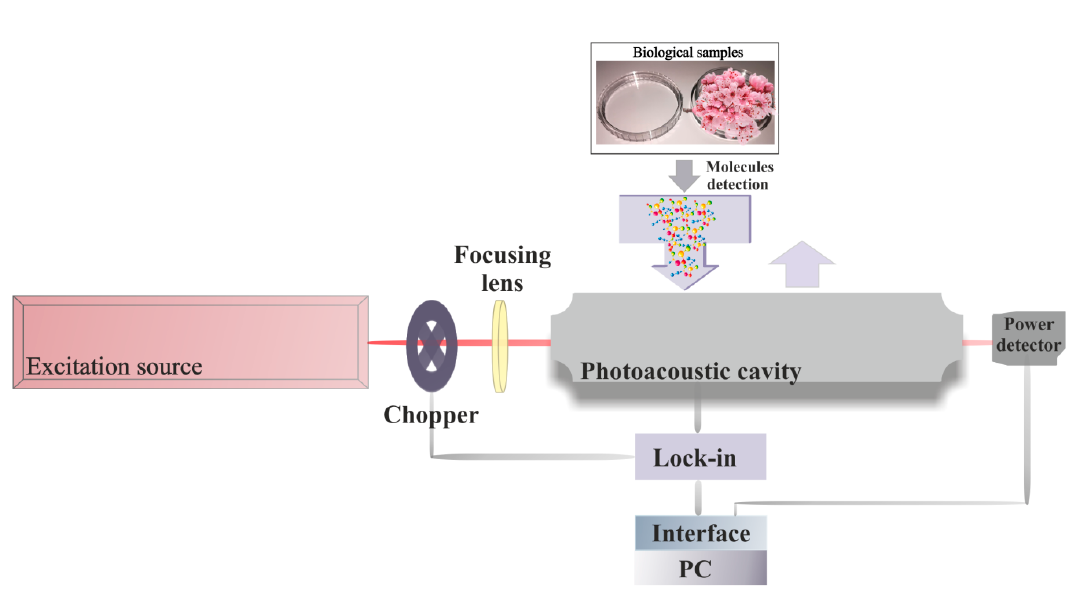
Figure 2. CO 2 laser-based photoacoustic trace gas detection.